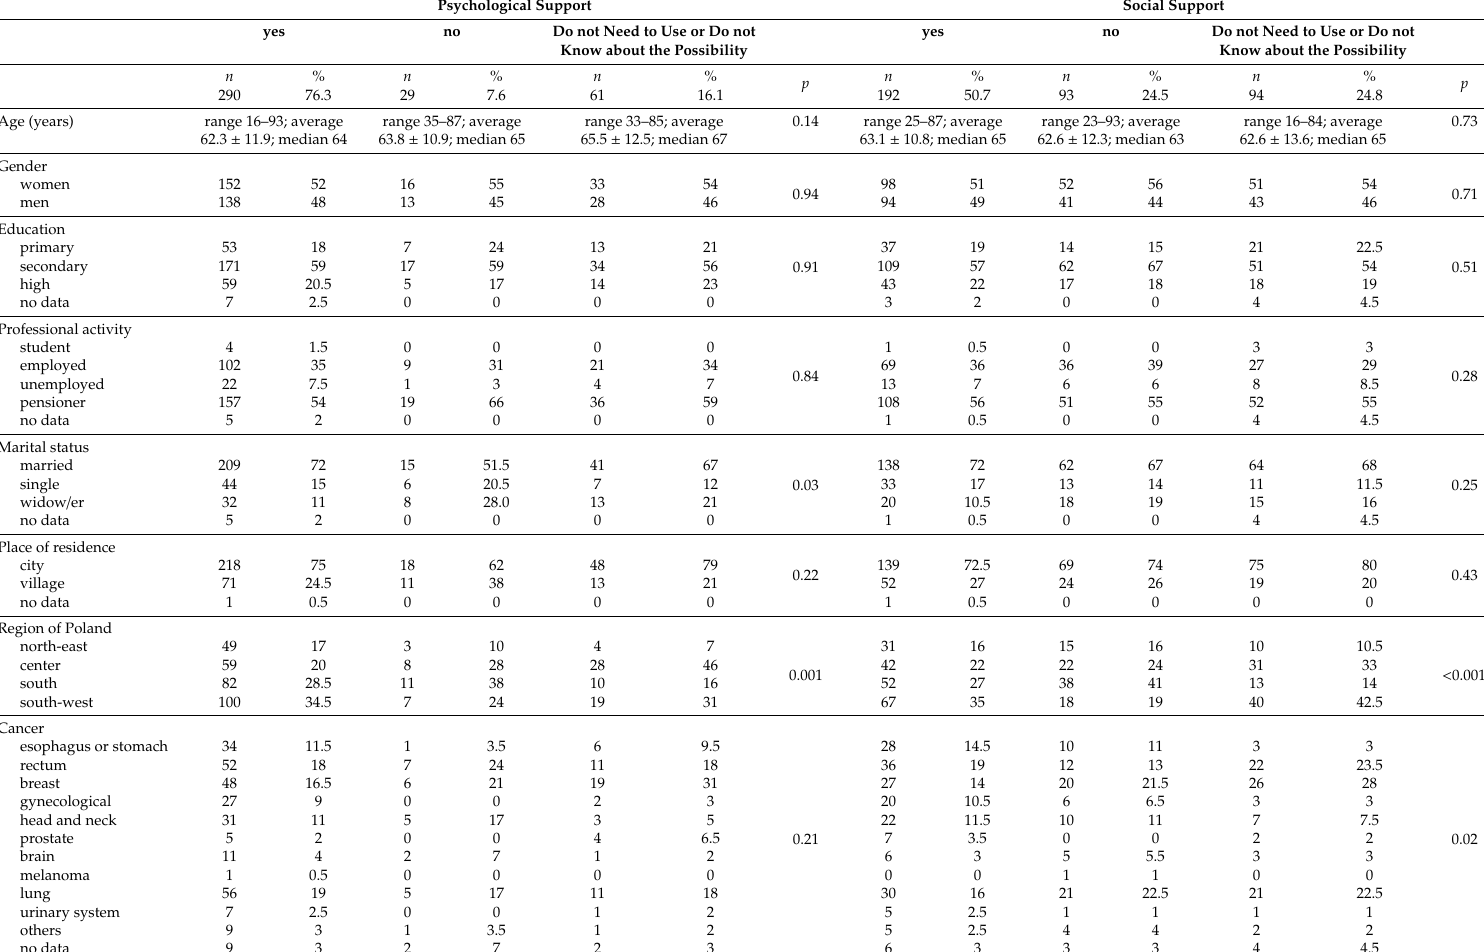
Table 3. Psychological and social support of